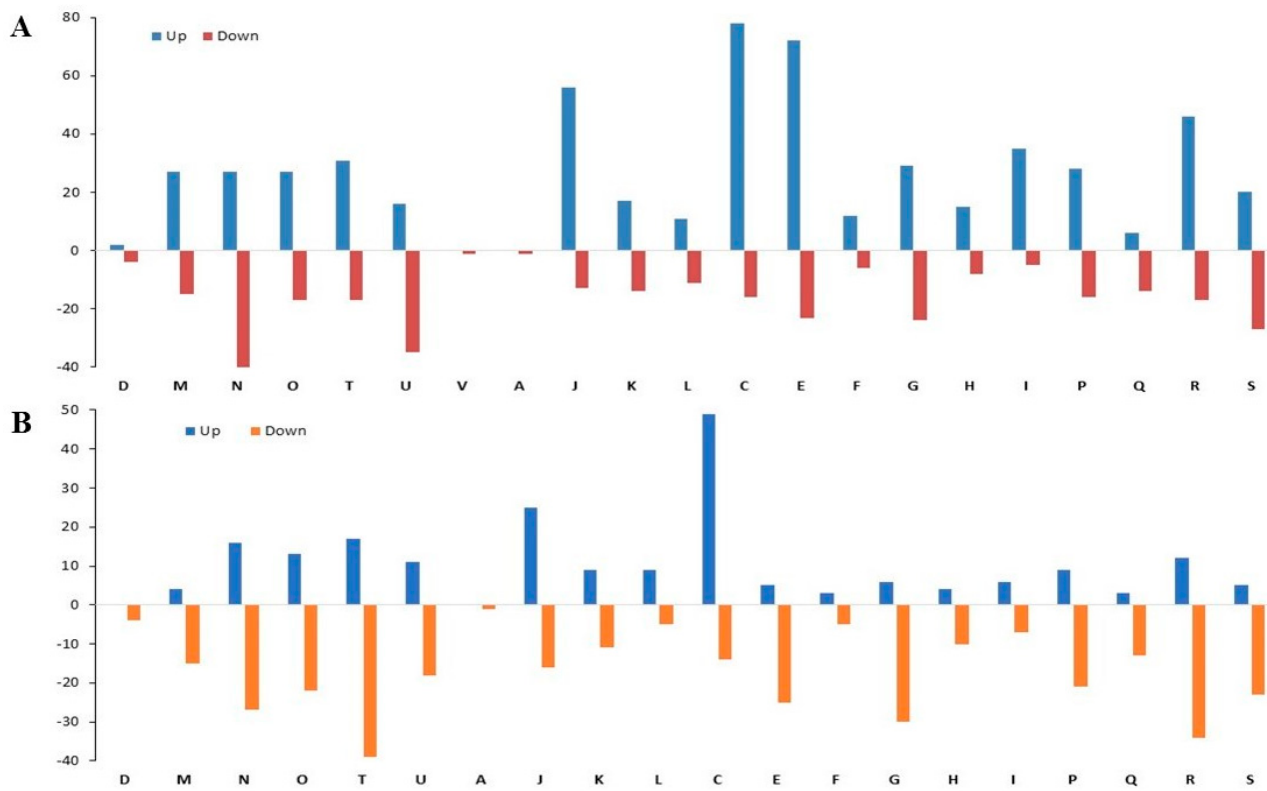
Figure 3. COG functional classification of the planktonic ( A ) and biofilm ( B ) cells grown with control and antibiotic-impregnated catheters. Y-axis with positive and negative values referring to upregulated and downregulated proteins, respectively. CELLULAR PROCESSES AND SIGNALING; (D) cell cycle control, cell division and chromosome partitioning; (M) cell wall/membrane/envelope biogenesis; (N) cell motility; (O) post-translational modification, protein turnover and chaperones; (T) signal transduction mechanisms; (U) intracellular trafficking, secretion and vesicular transport; (V) defense mechanisms. INFORMATION STORAGE AND PROCESSING; (A) RNA processing and modification; (J) translation, ribosomal structure and biogenesis; (K) transcription; (L) replication, recombination and repair. METABOLISM; (C) energy production and conversion, (E) amino acid transport and metabolism; (F) nucleotide transport and metabolism; (G) carbohydrate transport and metabolism; (H) coenzyme transport and metabolism; (I) lipid transport and metabolism; (P) inorganic ion transport and metabolism; (Q) secondary metabolites biosynthesis, transport and catabolism; POORLY CHARACTERIZED; (R) general function prediction only; (S) function unknown.